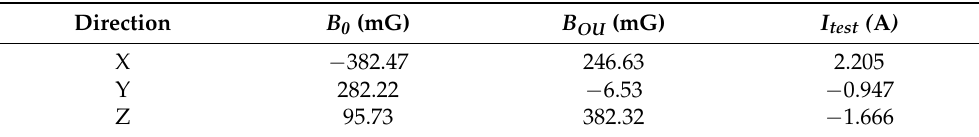
Table 2. Helmholtz cage parameters, where B 0 is the initial magnetic field at the Helmholtz cage centre, B OU is the magnetic field (NED coordinates) in Ourense (Spain) according to IGRF models, and I test is the current intensity values used during the test. Direction B 0 (mG) B OU (mG) I test ( A ) X − 382.47 246.63 Y 282.22